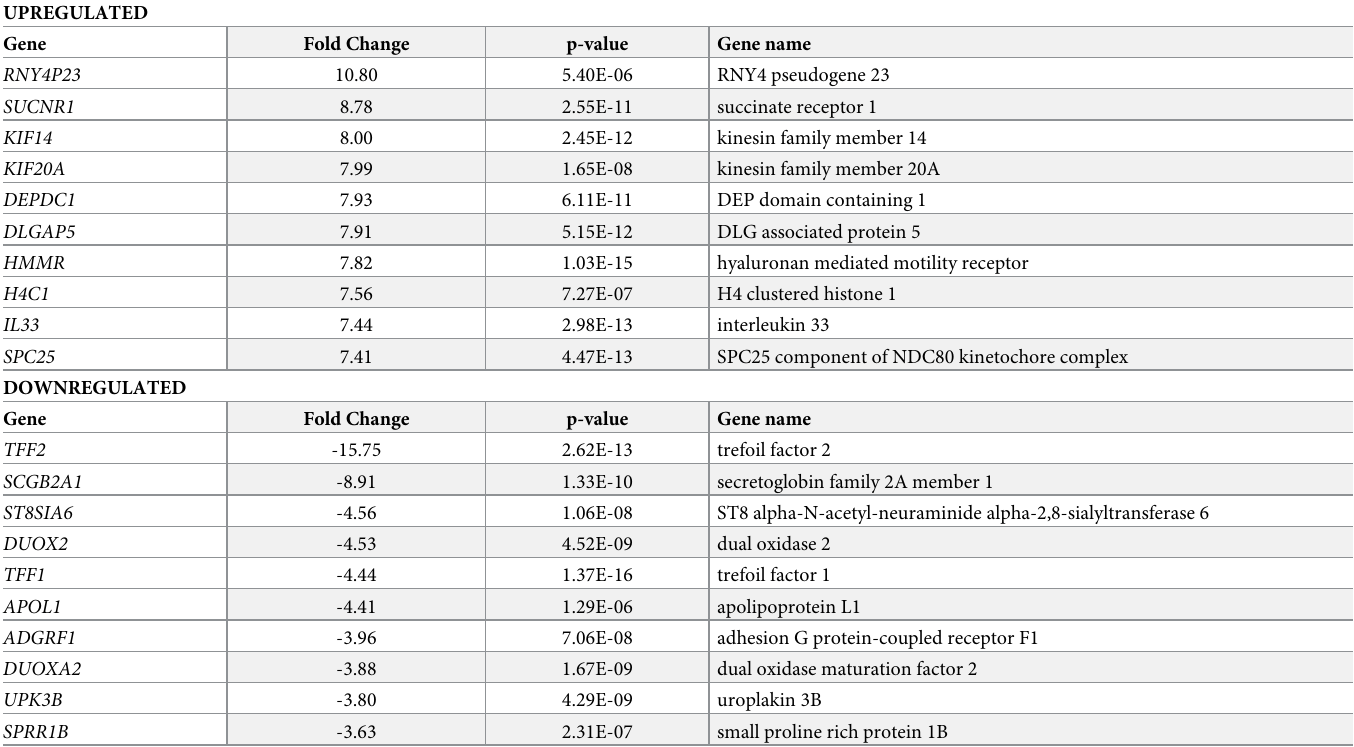
Table 1. Top 10 strongest up- and downregulated genes in HT29-MTX-E12 cells grown under SWMS versus static conditions. UPREGULATED